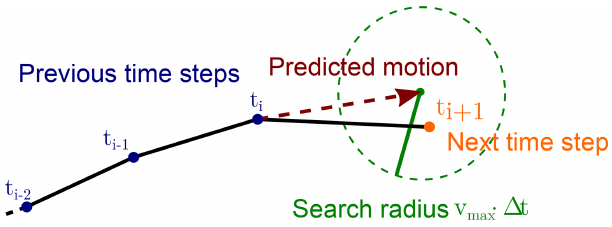
Figure 3. Schematic illustration of the trajectory linking with the predicted motion of the feature based on previous time steps and a search range around the predicted